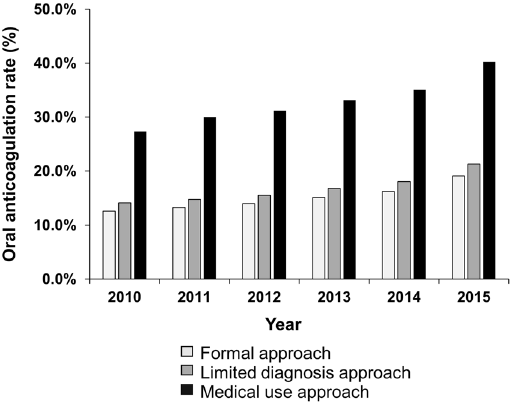
Figure 2. The change of oral anticoagulation rate according to different analysis approaches in overall atrial fibrillation